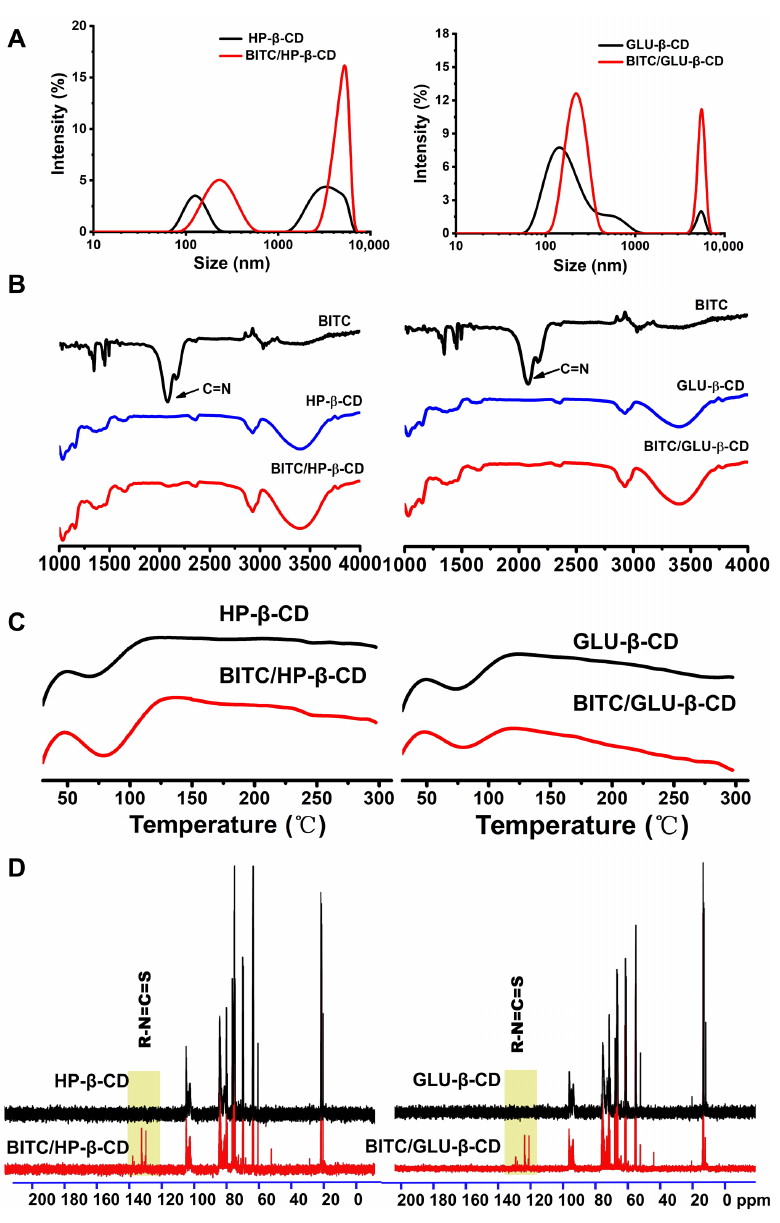
1 Figure 2. ( A ) Particle size of two β -cyclodextrin derivatives, including BITC. ( B ) IR spectra of free BITC, β -CD, and BITC inclusion complexes. ( C ) DSC spectra of β -CD and inclusion complexes. ( D ) 1 H-NMR spectra of β -CD and inclusion